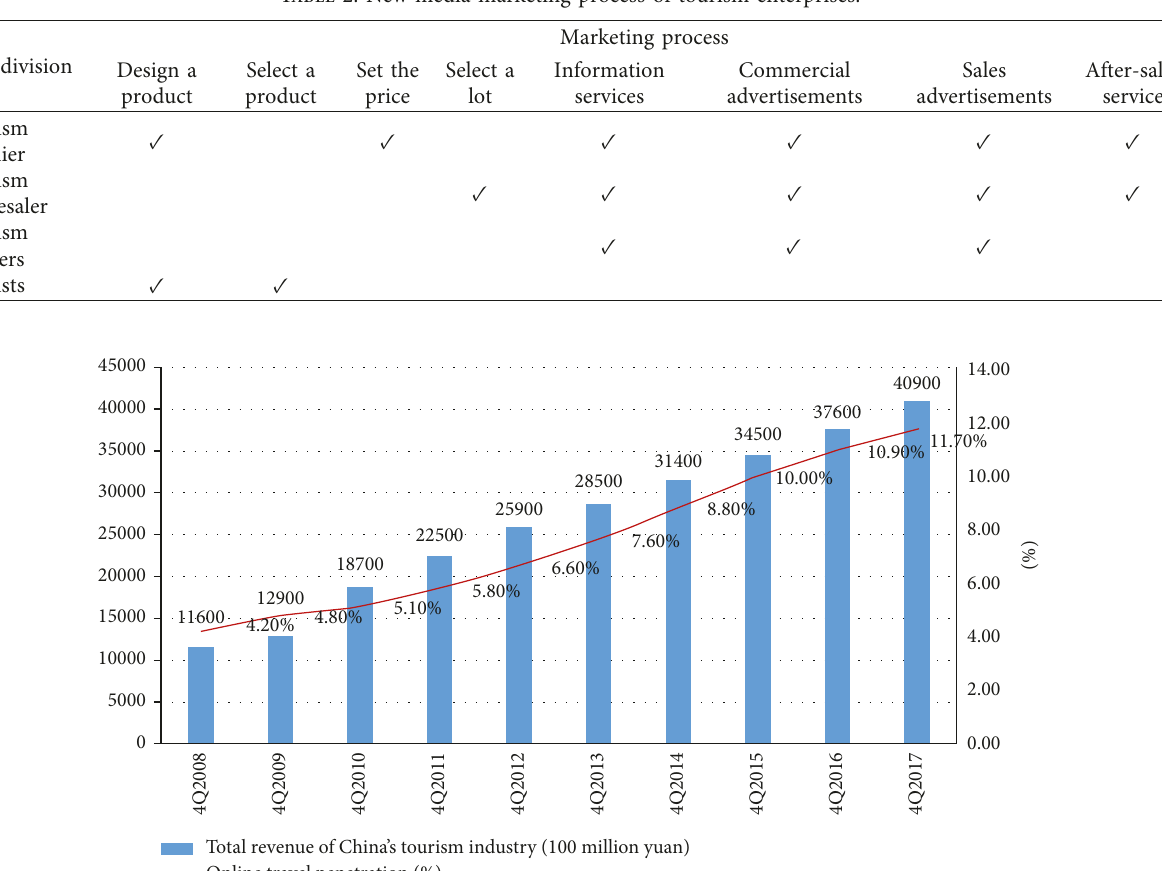
✓ Table 2: New media marketing process of tourism